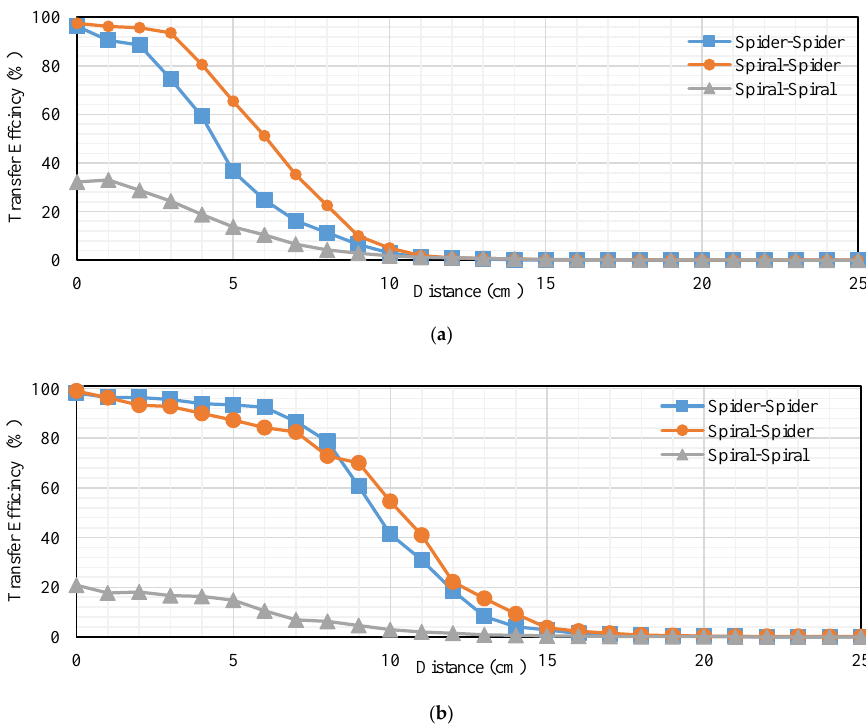
Figure 19. Transfer efficiency of RL based topologies into: ( a ) 40 Ω and ( b ) 200 Ω. Figure 19. Transfer e ffi ciency of RL based topologies into: ( a ) 40 Ω and ( b ) 200 Ω The transfer distance in centimeters is plotted on the x-axis , and the transfer power on RxC at RL in watts plotted on the y-axis . Figure 20a,b, indicates the measured transfer power on RxC into 40 and 200 Ω. Figure 20a, indicates the measured transfer power on RxC into 40 Ω. The spider – spider topology is the best compared with other topologies at 1 – 4 cm, it was 68.2 W at 3 cm. Also, the spiral – spider topology is effective compared with the other topologies at 5 – 25 cm, it was 36 and 0.2 W at 5 and 15 cm, respectively. Figure 20 b, indicates the measured transfer power on RxC into a 200 Ω load, the spider – spider topology performed the best compared with other topologies at 1 – 6 cm, it was 90.2 and 111 W at 2 and 5 cm, respectively. Transfer power for spider – spider and spiral – spider topologies were almost equal at 7 – 25 cm, it was 30.8 and 30 at 10 cm for these topologies, respectively. Spiral – spider behavior this shape for a specific reason is that the amount of transfer power between coils is low due to the extra load on the oscillator, which affects the low energy entering the oscillator and affects the value of self-induction and mutual induction.